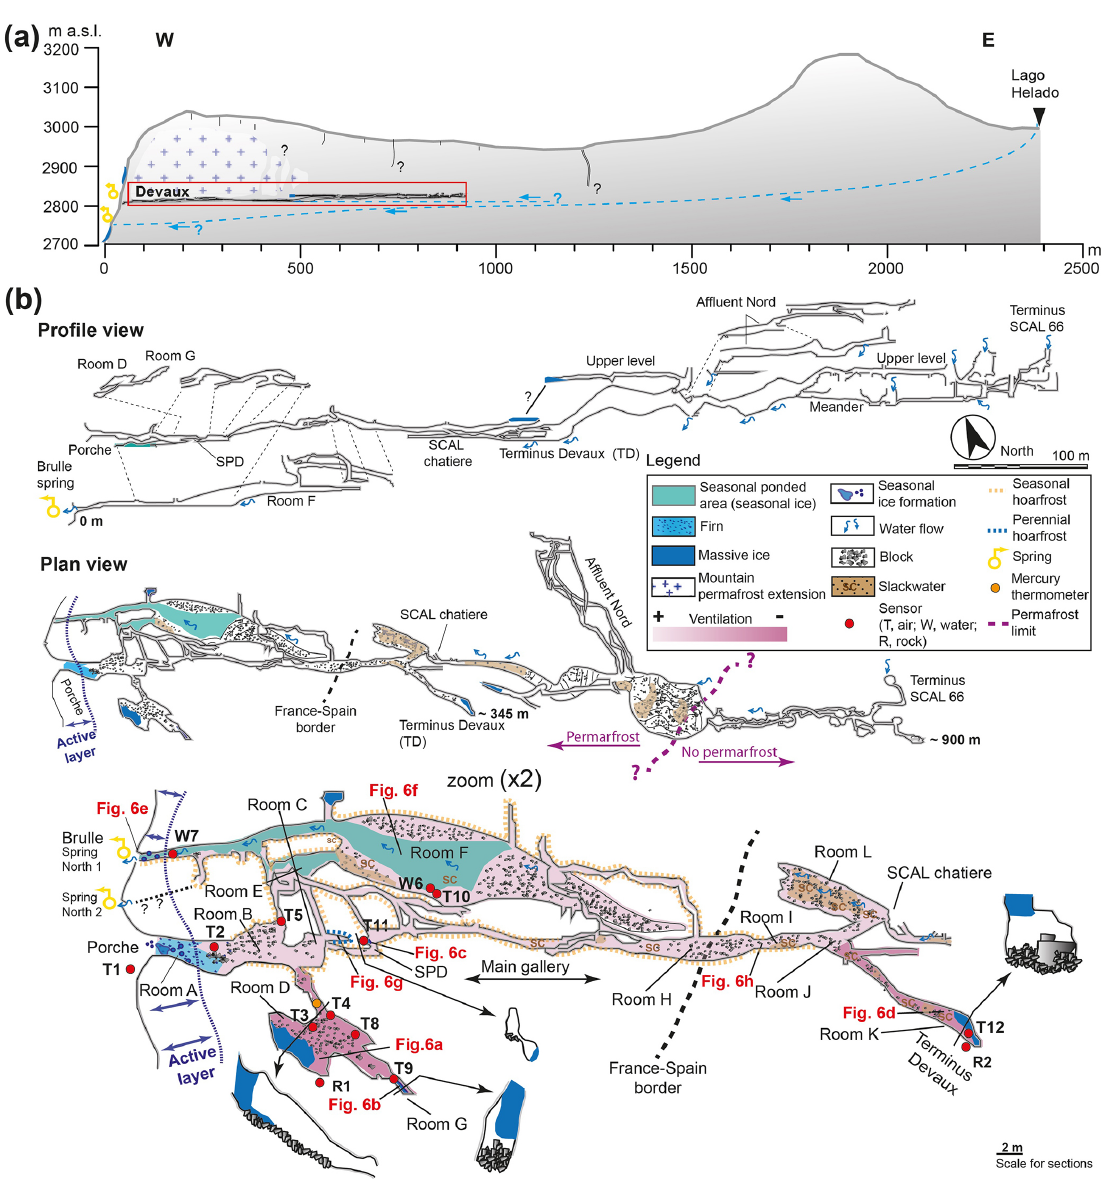
Figure 2. (a) Schematic west–east cross-section from Lago Helado to Devaux cave, the assumed extent of mountain permafrost, and the interpreted underground flow path according to du Cailar et al. (1953). (b) Longitudinal section and plan view of Devaux cave showing the locations of sensors and cave deposits. Labels R, W, and T refer to rock, water, and air temperature sensors, respectively. The enlarged area corresponds to the first ∼ 345m of the studied sector. Red labels correspond to the approximate location of the photographs in Fig. 6. Cave survey by Marc Galy, Groupe Spéléologique des Pyrénées (GSPY